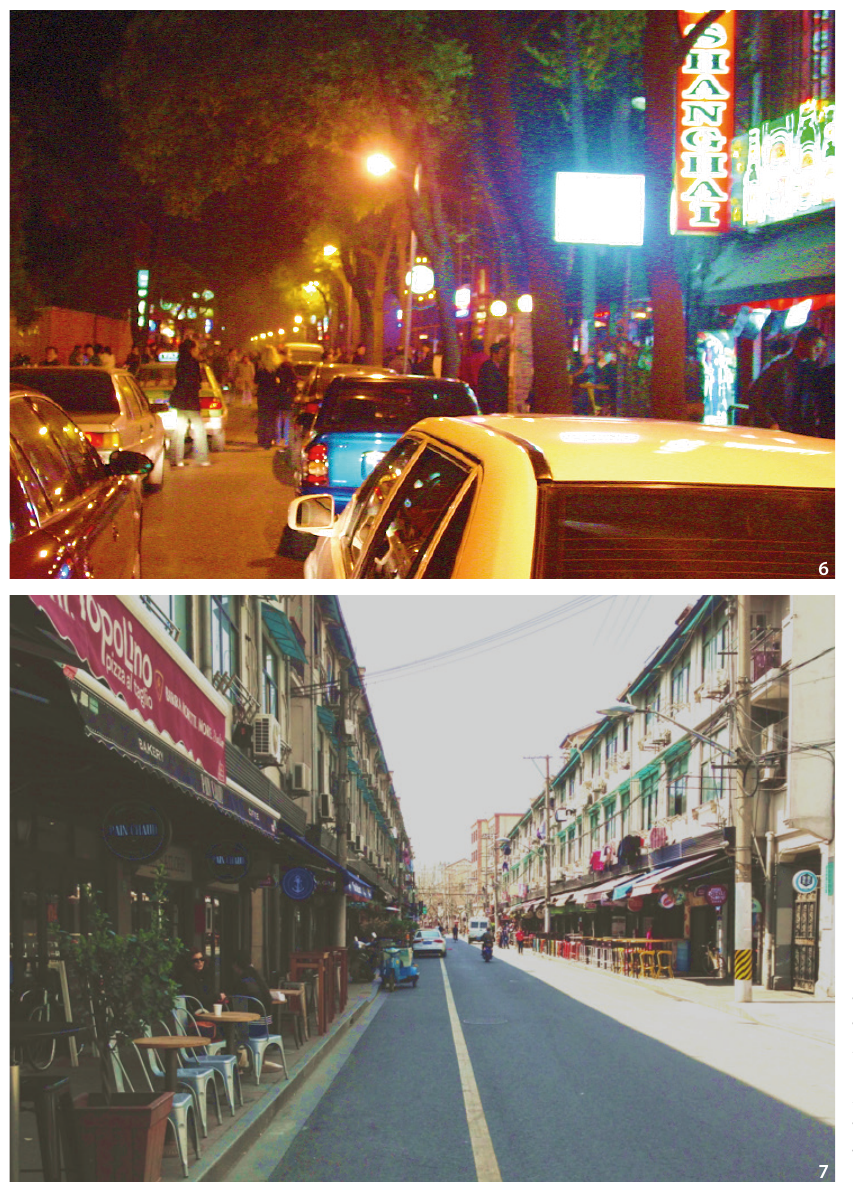
Figure 6 Traffic jams were one common complaint among visitors and area resi- dents on South Maoming Road in summer 2000 (Source: the author). Figure 7 At its height of activity in 2013 small bars lined both sides of the street on Yongkang Road. Quiet in the daytime, at night customers spilled into the